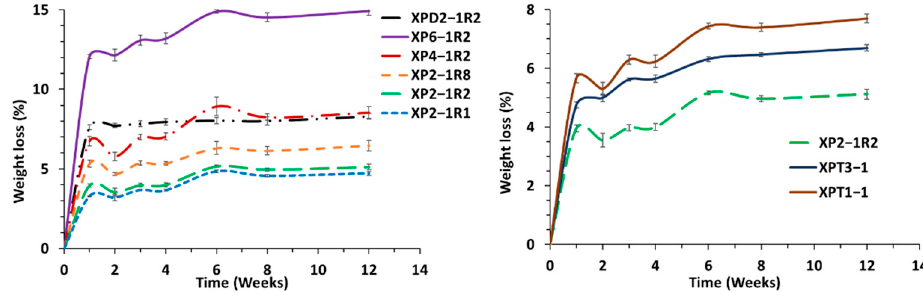
Figure 8. Evolution of the xerogels degradations (weight loss in %) in PBS at 37 °C for 12 weeks.